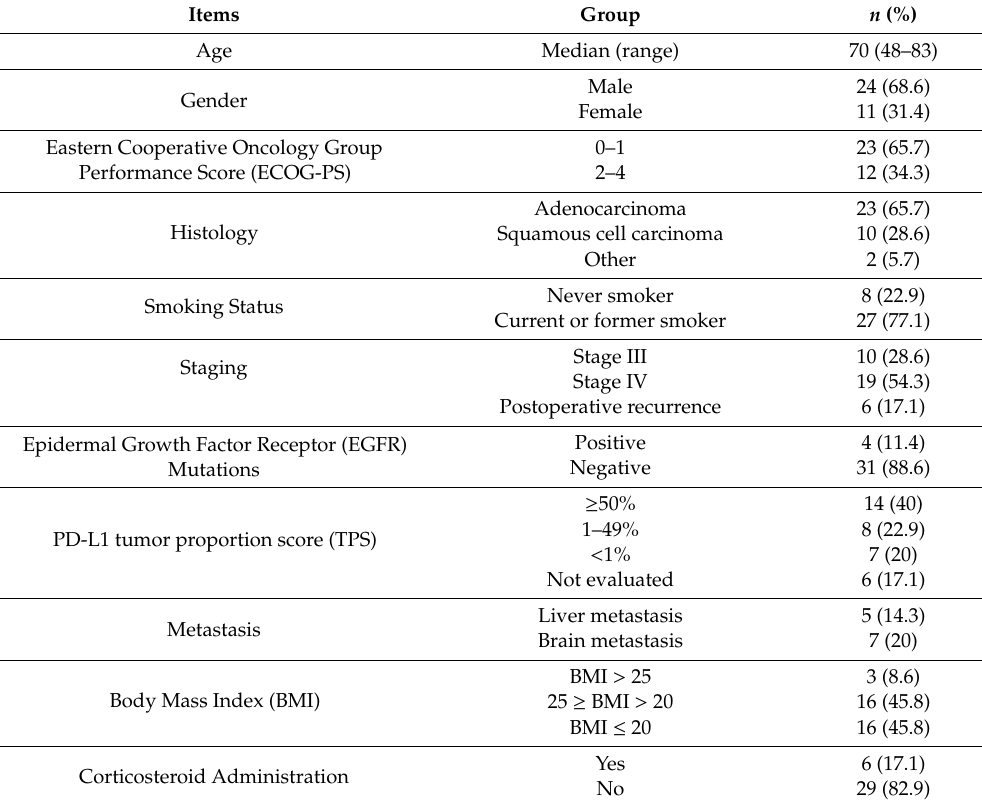
Table 1. Patient characteristics at immune checkpoint inhibitor (ICI) rechallenge